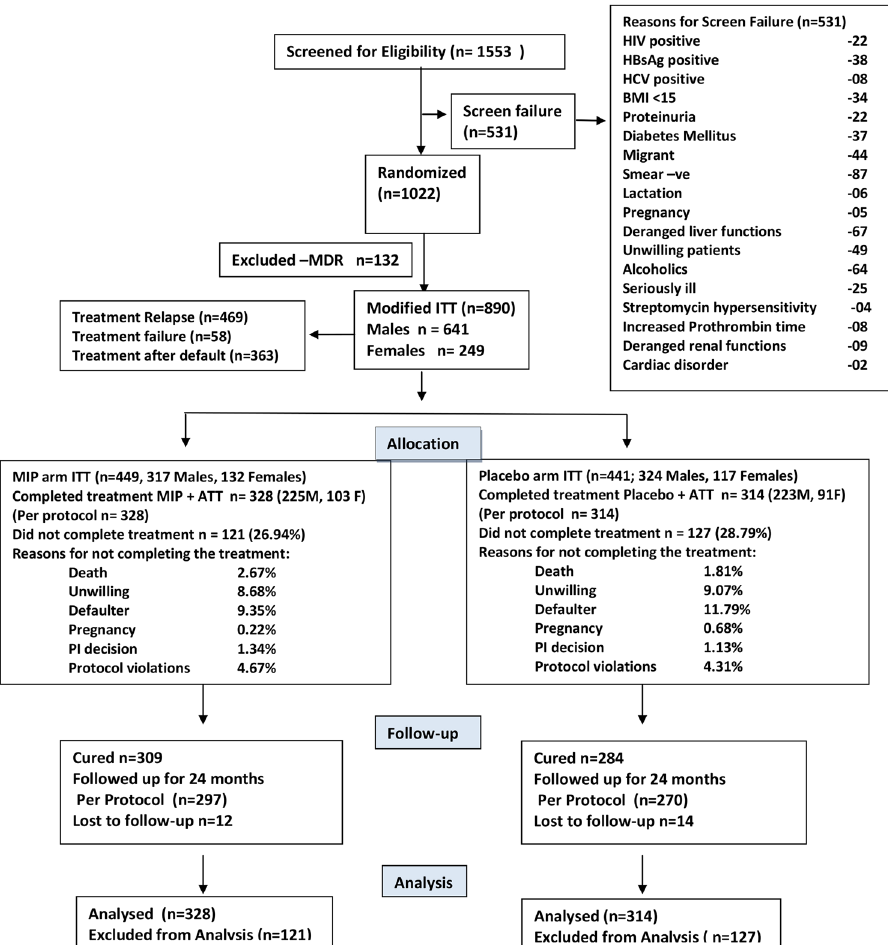
Figure 1. CONSORT Flow chart of Cat II patients screened, randomized, treated and analyzed. All randomized patients excluding MDRs (at baseline) formed the Modified intention to treat (ITT) population whereas all patients who have completed 8/9 months of study treatment (including 12 weeks of intensive phase) formed the per protocol